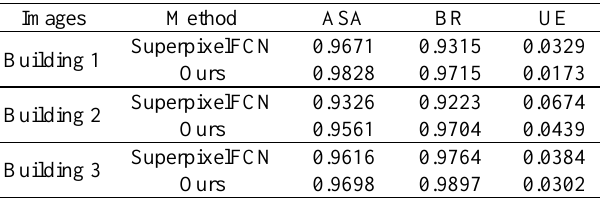
Table 1 . Comparison of superpixel segmentation results on evaluation